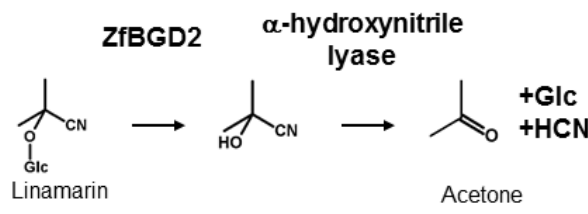
Figure 3. Hydrolysis of CNglcs exemplified by the aliphatic CNglc linamarin and the characterised β - glucosidase and envisioned α -hydroxynitrile lyase enzymes from Z. filipendulae .